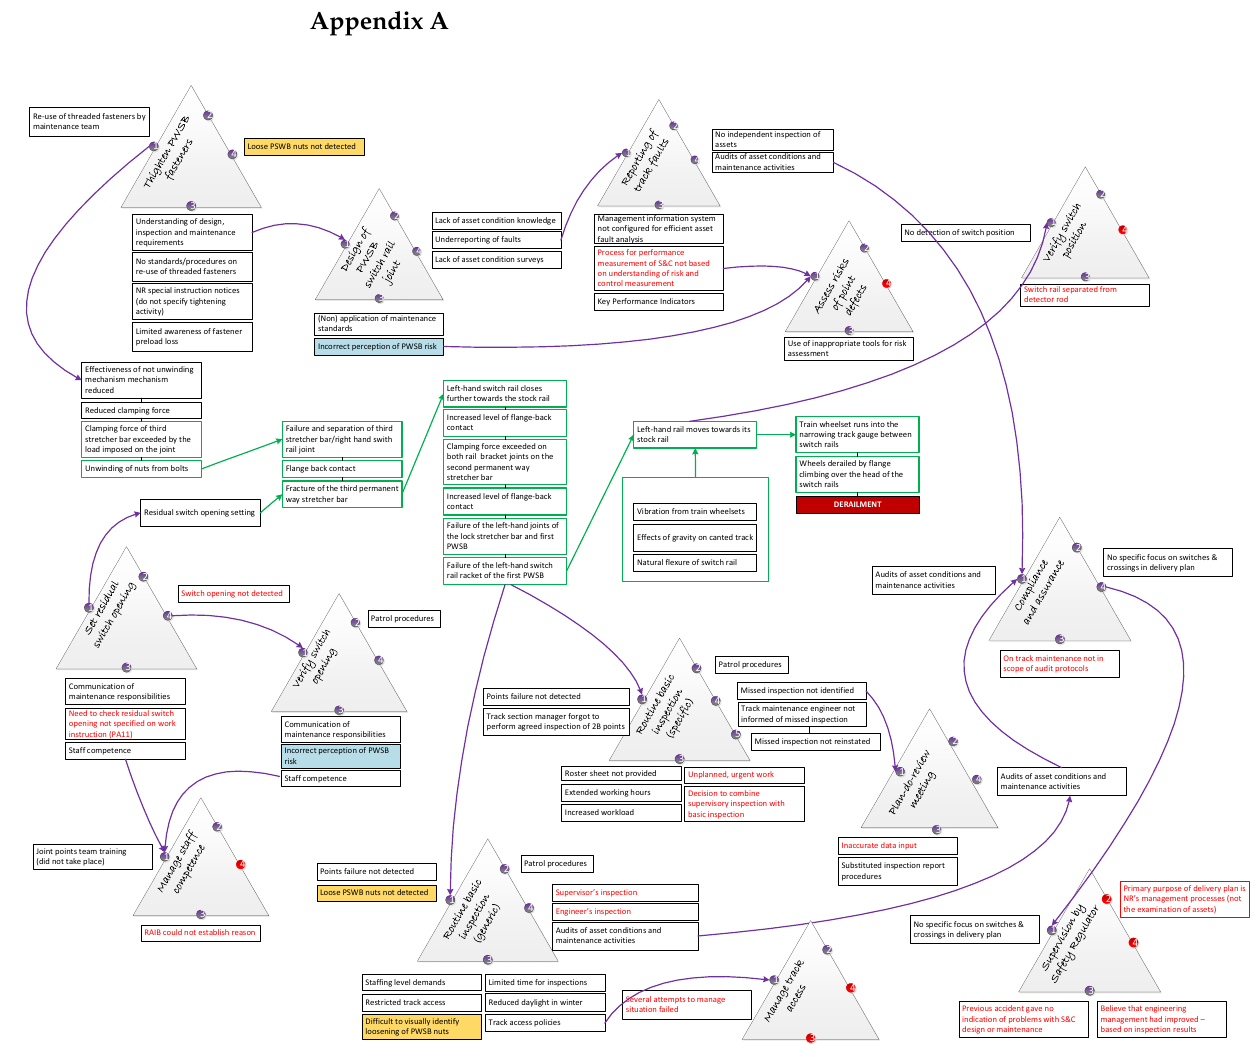
Figure A1. SAFRAN representation of the Grayrigg accident.